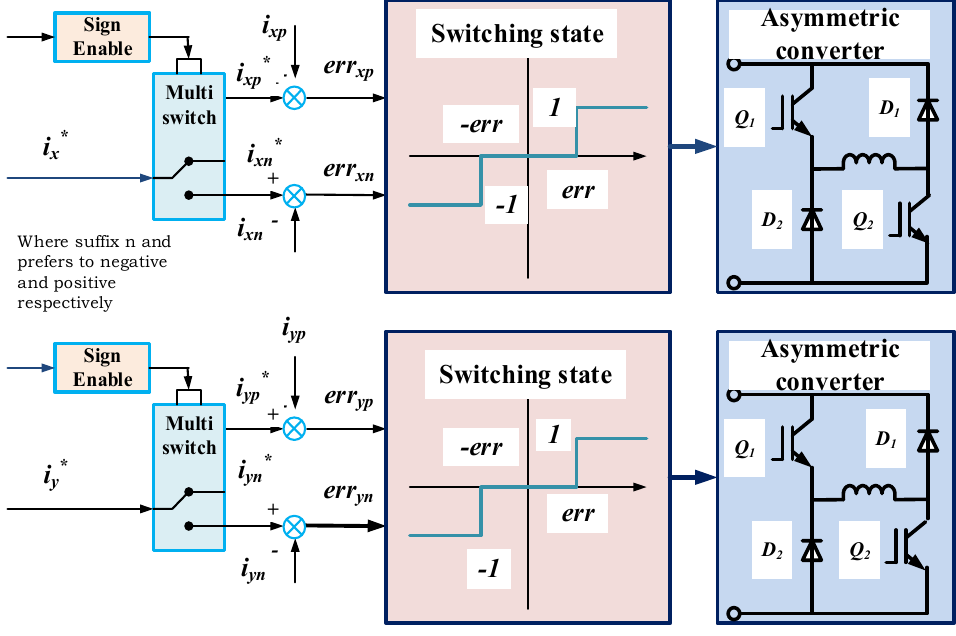
Figure 8. Switching block diagram for suspension control.